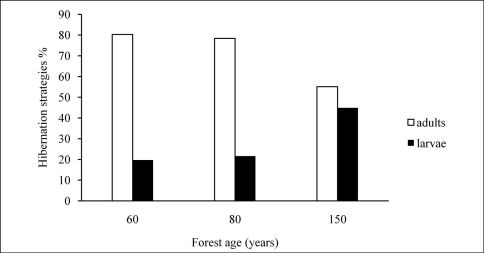
Proportion of species according to their hibernation strategies (larvae – black columns, adults – white columns) in relation to forest age (years).